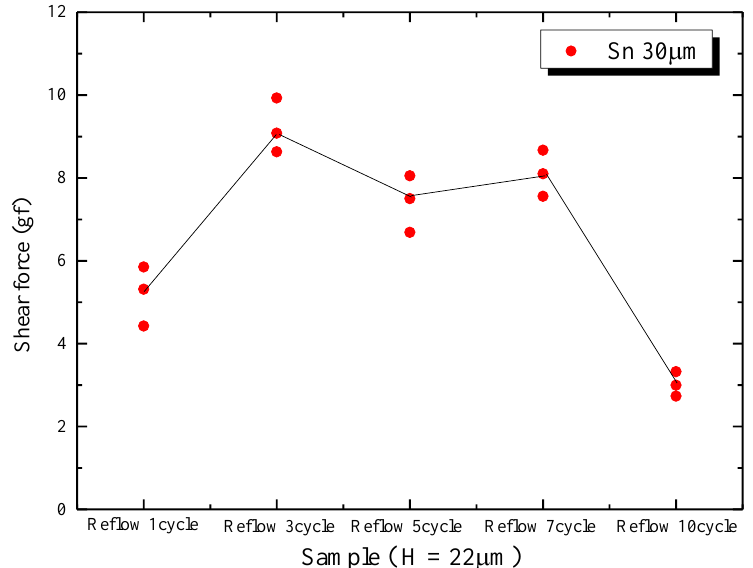
Figure 10. Maximum, minimum, and average values of shear strength according to the number